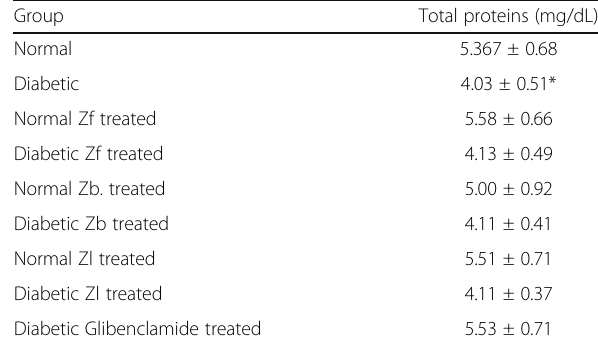
Table 3 The effect of extracts of Zanthoxylum armatum and standard drug Glibenclamide on Hb level of normal and diabetic mice